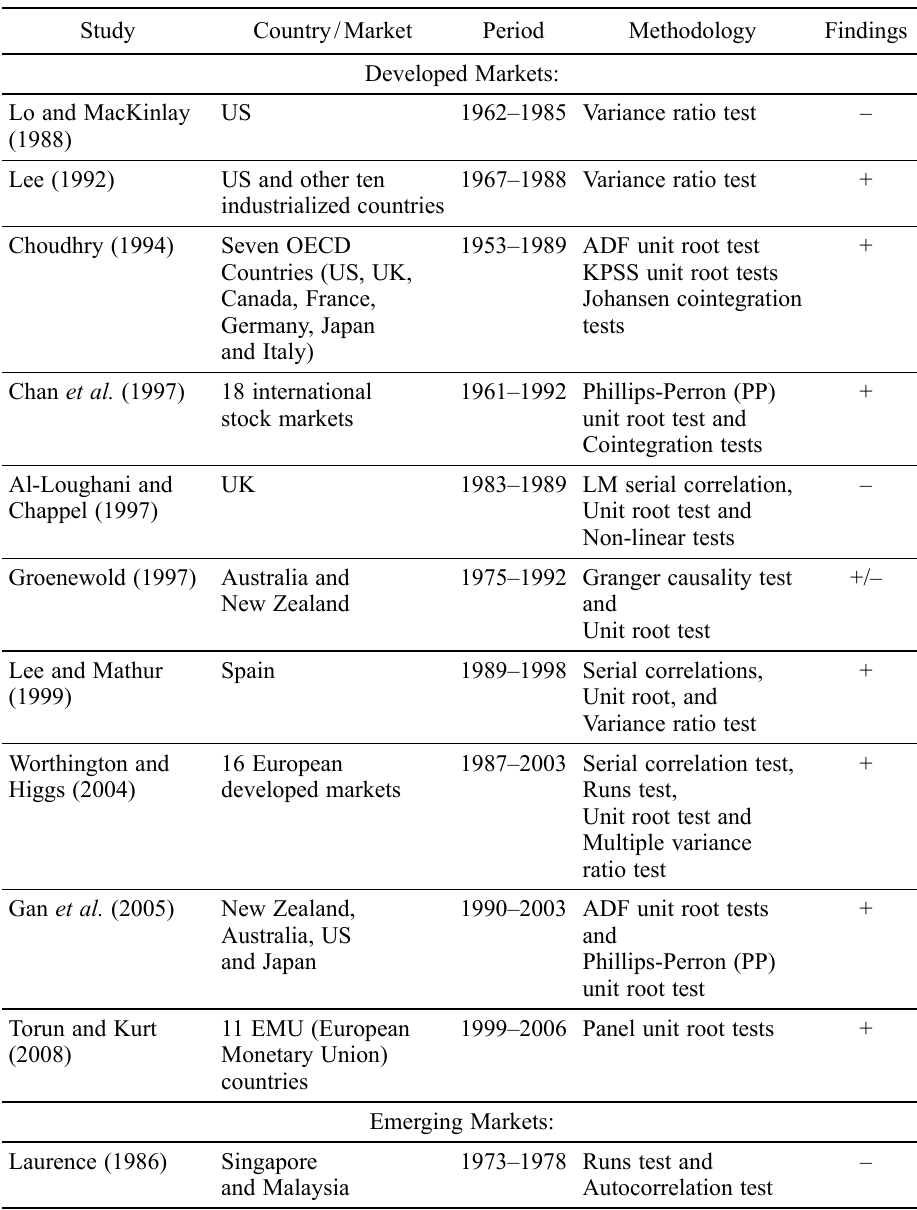
Period Methodology